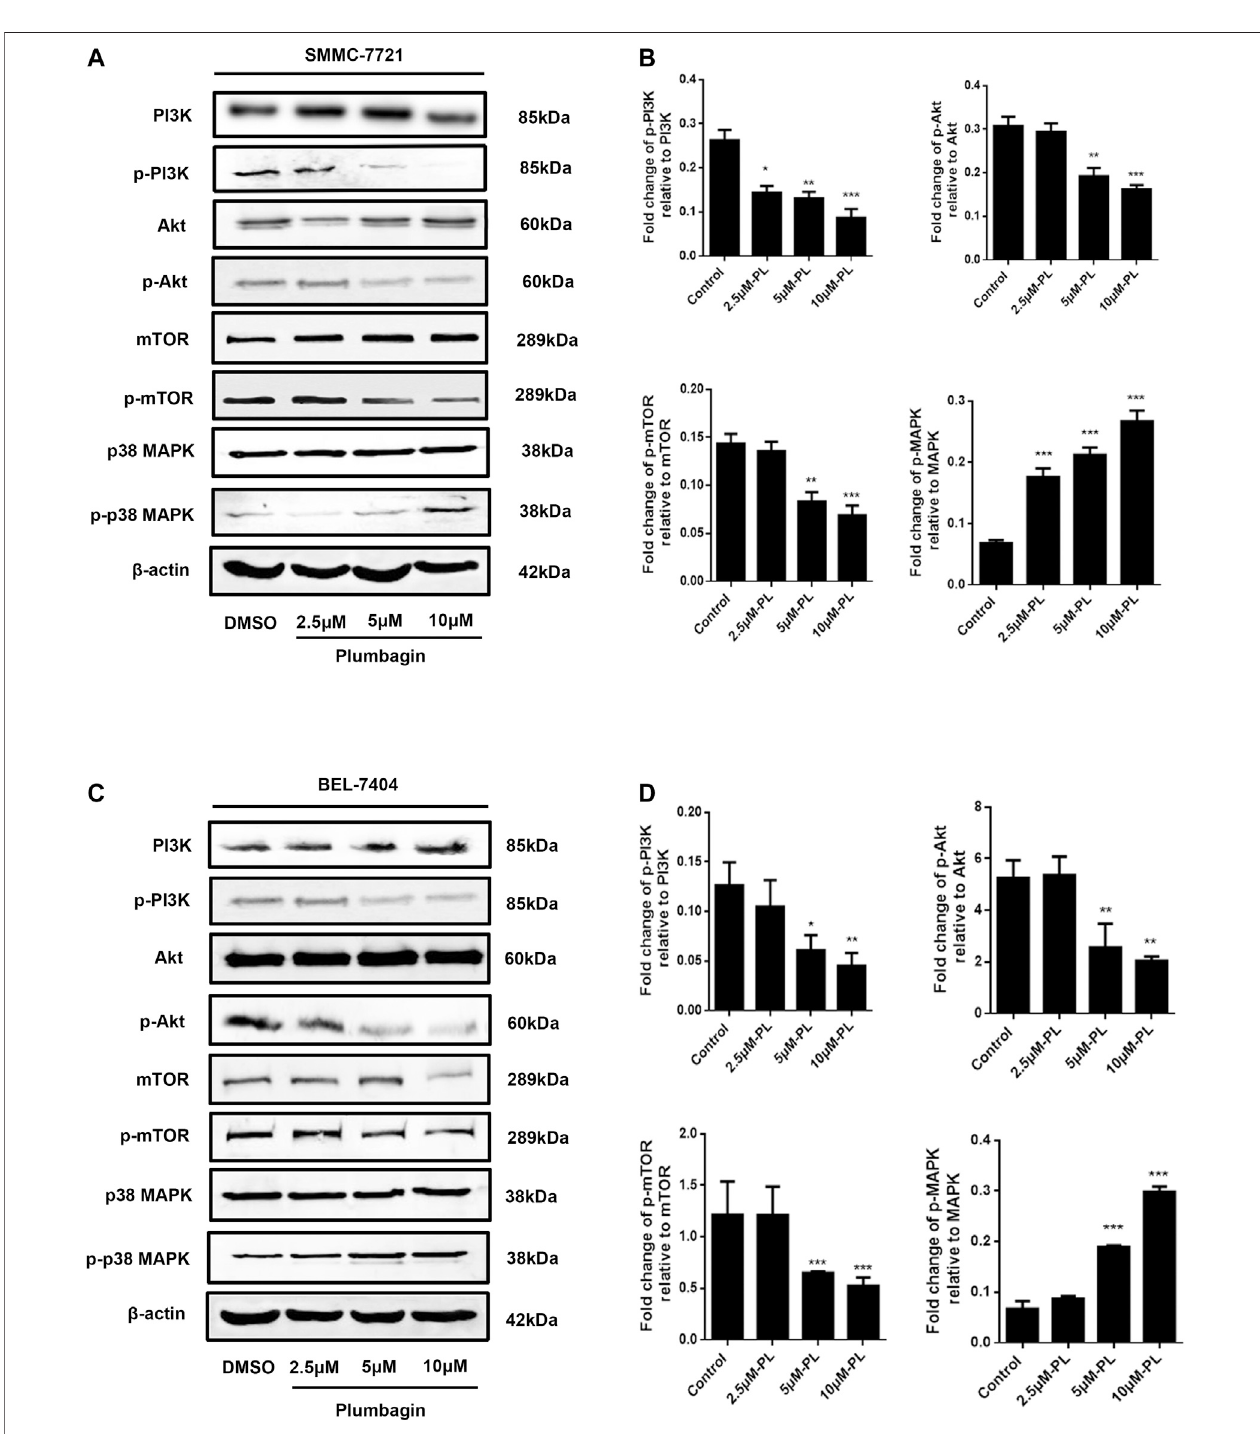
FIGURE 6 | (A) Protein expression levels of PI3K, p-PI3K, Akt, p-Akt, mTOR, p-mTOR, MAPK, and p-MAPK in SMMC-7721 cells measured by Western blot after treatment with various concentrations of PL (0.5, 2.5, 5, and 10 μ M). (B) PI3K, MAPK, Akt, and mTOR were used as internal reference total proteins for gray value analysis. Each bar represents the mean value ± standard deviation (SD) of the intensity of PL-induced cells across triplicate experiments. * p < 0.05, ** p < 0.01 *** p < 0.001, compared with the control group. (C) Protein expression levels of PI3K, p-PI3K, AKT, p-AKT, mTOR, p-mTOR, MAPK, and p-MAPK in BEL-7404 cells measured by Western blot after treatment with various concentrations of PL (0.5, 2.5, 5, and 10 μ M). (D) PI3K, MAPK, Akt, and mTOR were used as internal reference total proteins for gray value analysis. Each bar represents the mean value ± standard deviation (SD) of the intensity of PL-induced cells across triplicate experiments. * p < 0.05, ** p < 0.01 *** p < 0.001, compared with the control group.